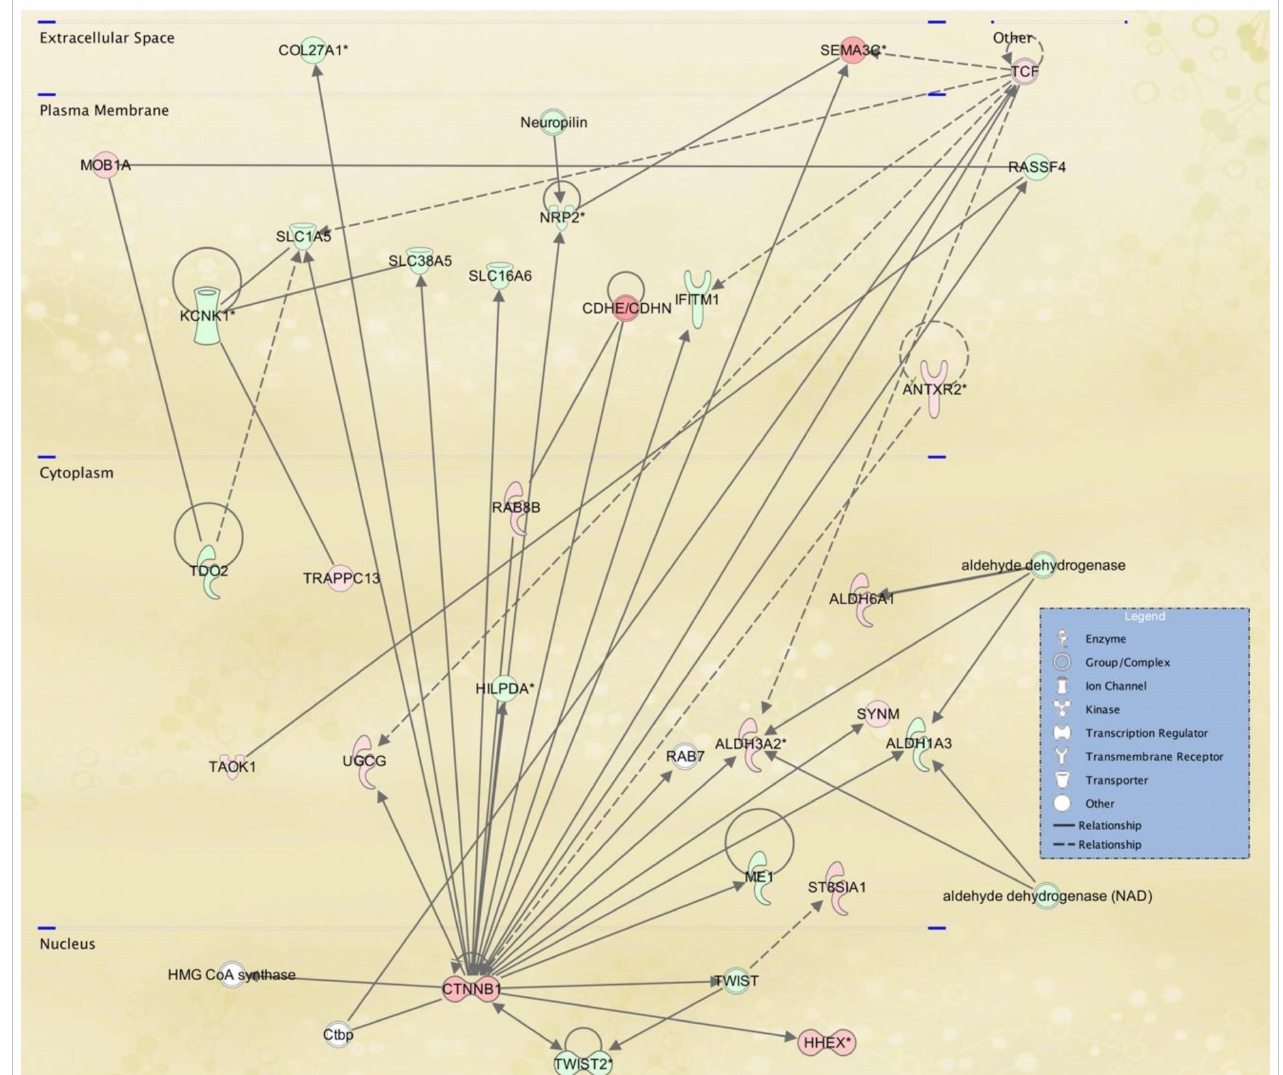
Figure 3. Lipid metabolism, molecular transport, small molecule biochemistry IPA network 2 affected in SS patient fibroblasts. IPA network 2 is centered in catenin beta. According to the Catenin beta Gene page in NCBI, this protein “anchors the actin cytoskeleton and may be responsible for transmitting the contact inhibition signal that causes cells to stop dividing once the epithelial sheet is complete” as well as being “part of a complex of proteins that constitute adherens junctions (AJs) necessary for the creation and maintenance of epithelial cell layers”. TWIST2 is down-regulated in this network and is a known regulator of epithelial to mesenchymal transitions (EMT). In addition, TWIST2 (cid:48) s role in lipid metabolism was evidenced in the phenotypes exhibited by the Twist2 knockout mice